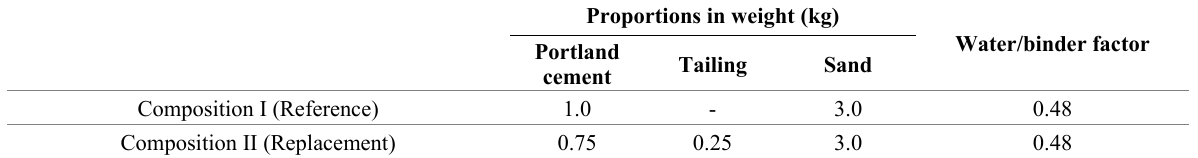
Table 1. Established proportions for molding